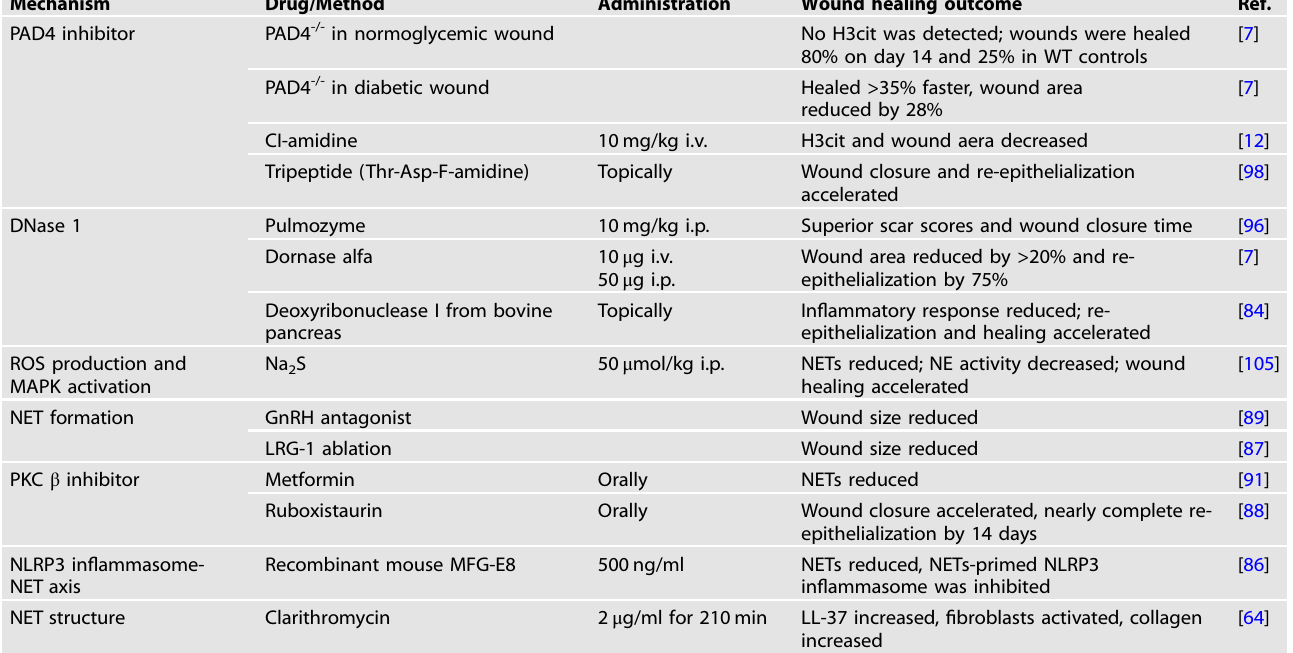
Table 1. Therapies targeting NETs in wound